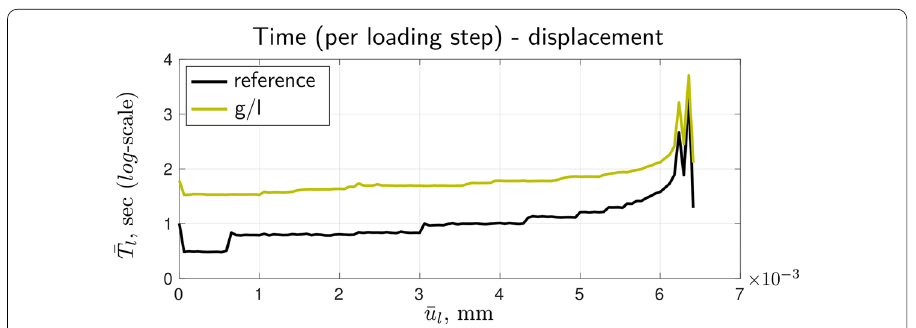
Fig. 11 Time-displacement curves in terms of ‘time per loading